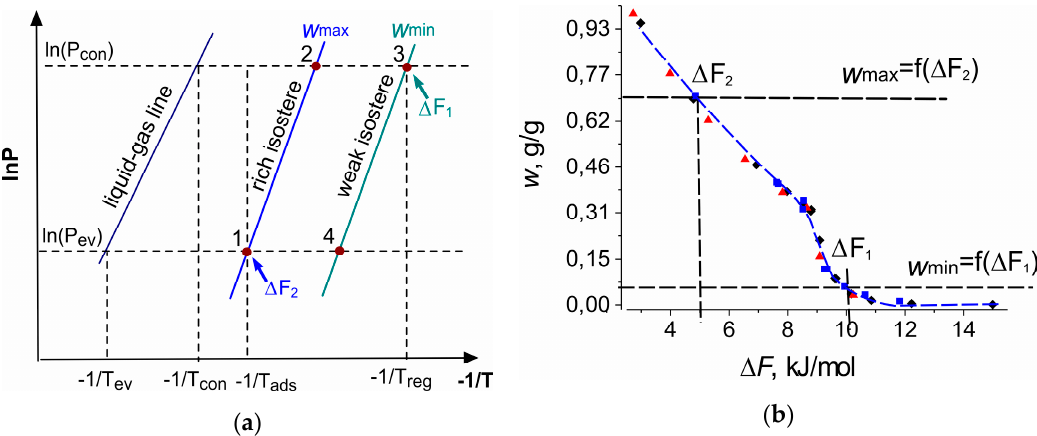
Figure 1. The P - T diagram of four temperature (4T) absorption heat transformation (AHT) cycle ( a ), and the universal adsorption curve plotted from experimental isobars of methanol sorption on the composite sorbent LiBr/MWCNT [21] measured at different pressures P 1 = 72.8 ( ), P 2 = 127.5 ( ), P 3 = 217.6 ( ) mbar ( b ).